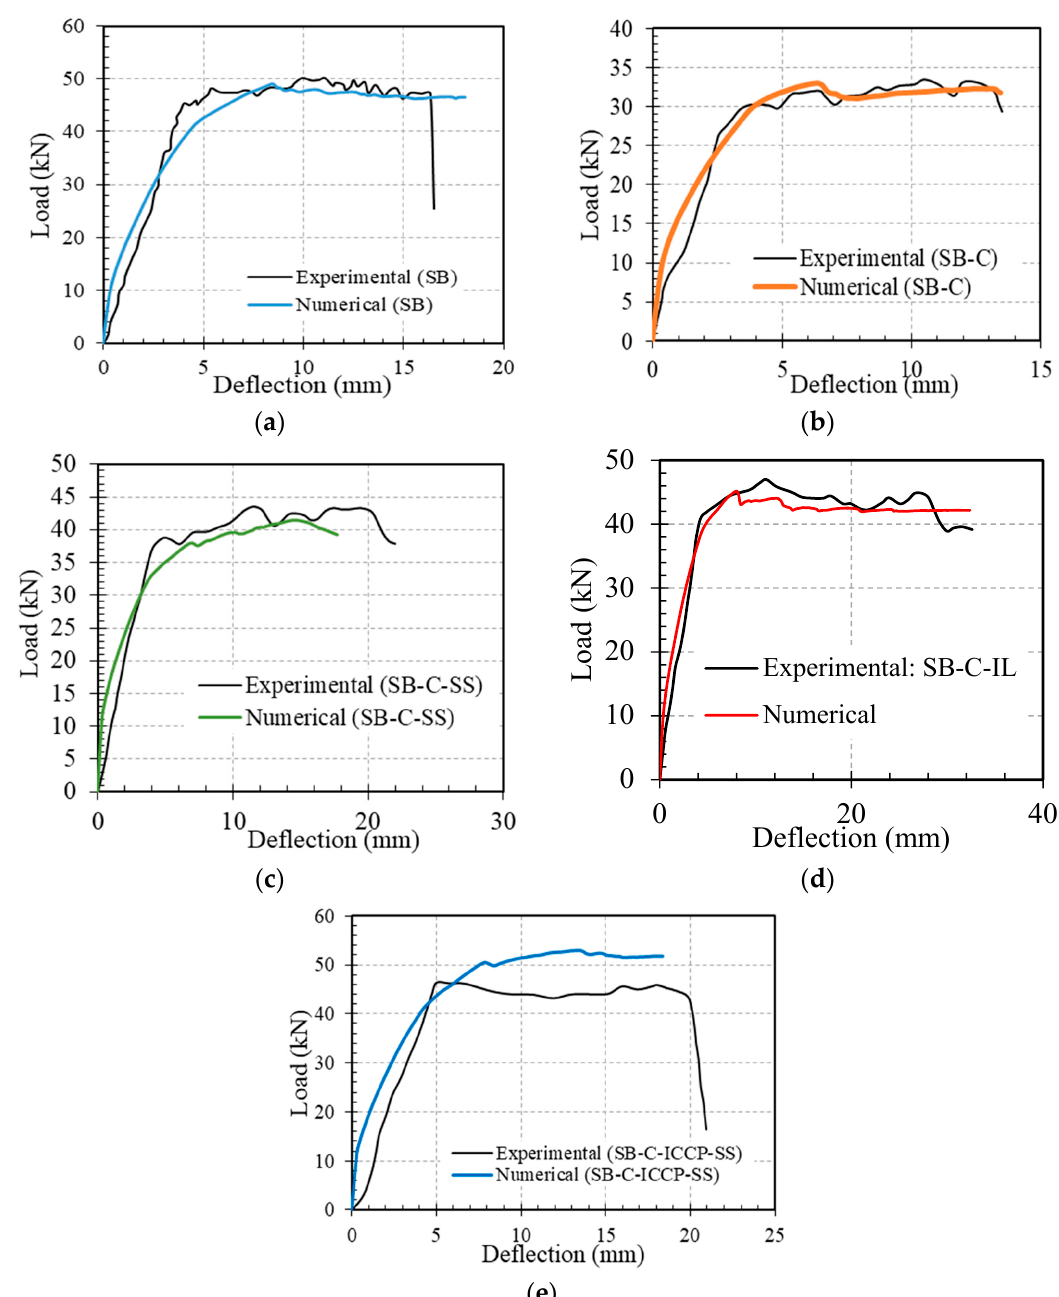
Figure 2. Comparison between experimental and numerical results: ( a ) the reference beam, ( b ) the beam with corroded steel bars, ( c ) the beam strengthened by a C-FRCM layer only, ( d ) the beam protected by ICCP only, and ( e ) the beam strengthened by ICCP-SS.